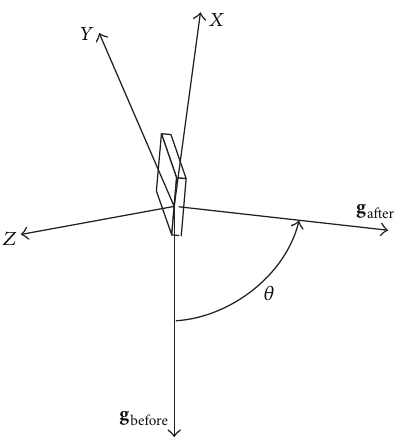
Figure 3: Rotation of gravity relative to fixed coordinate.